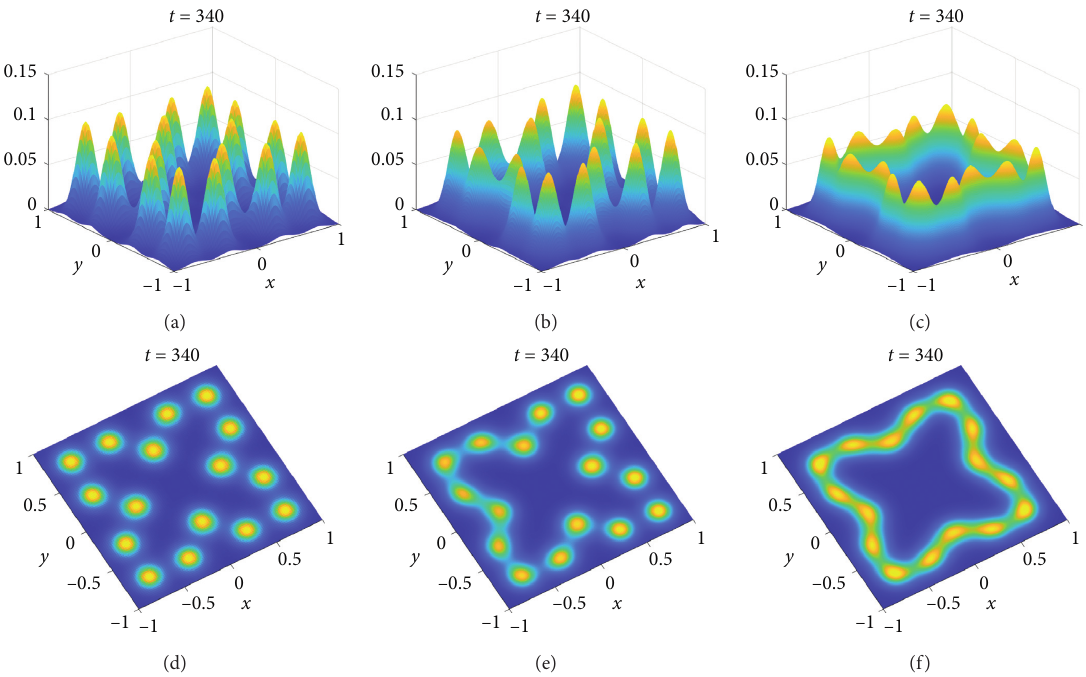
Figure 11: Numerical solutions for u Δ t � 0 . 1. The image I represents the aerial view of I